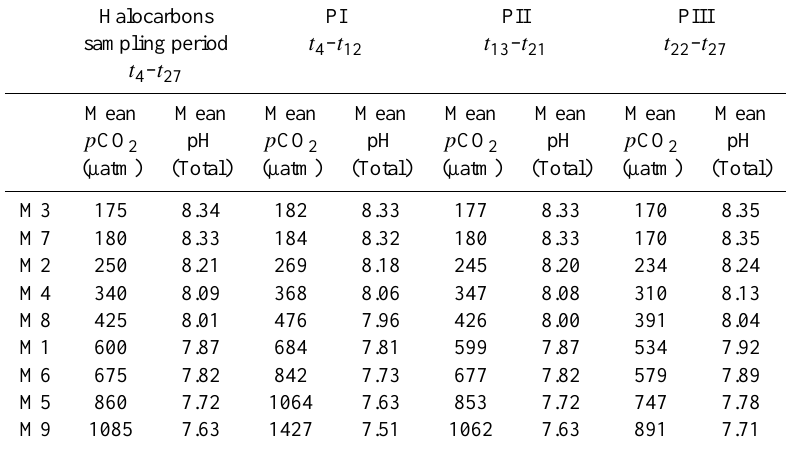
Table 1. Mean p CO 2 (µatm) and pH (on the total scale) for the halocarbon sampling period ( t 4 – t 27 ) and for each phase of the experiment referred to in this article. See Bellerby et al. (2012) for full details of the evolution of the carbonate system within the